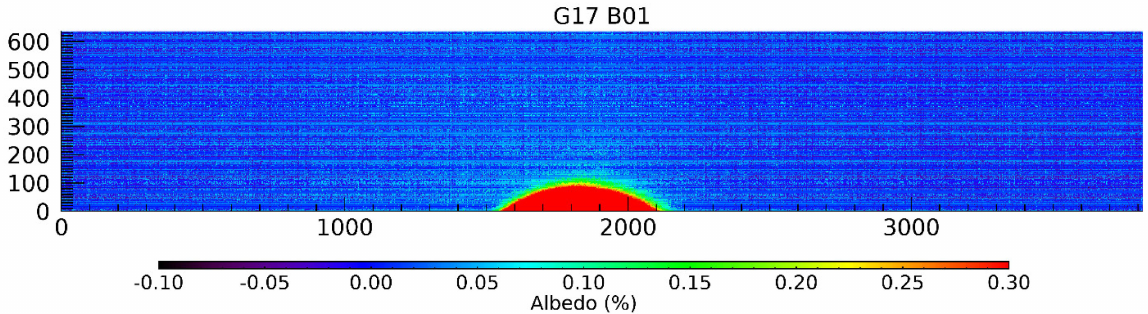
Figure 16. Albedo (%) of the sample from FD Swath #11 collected on 26 July 2018 at 19:15 UTC. The image is subsampled for every four samples in the EW direction.